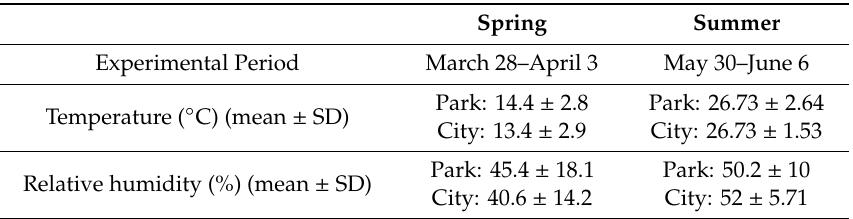
Table 1. Details of the experiment sites.